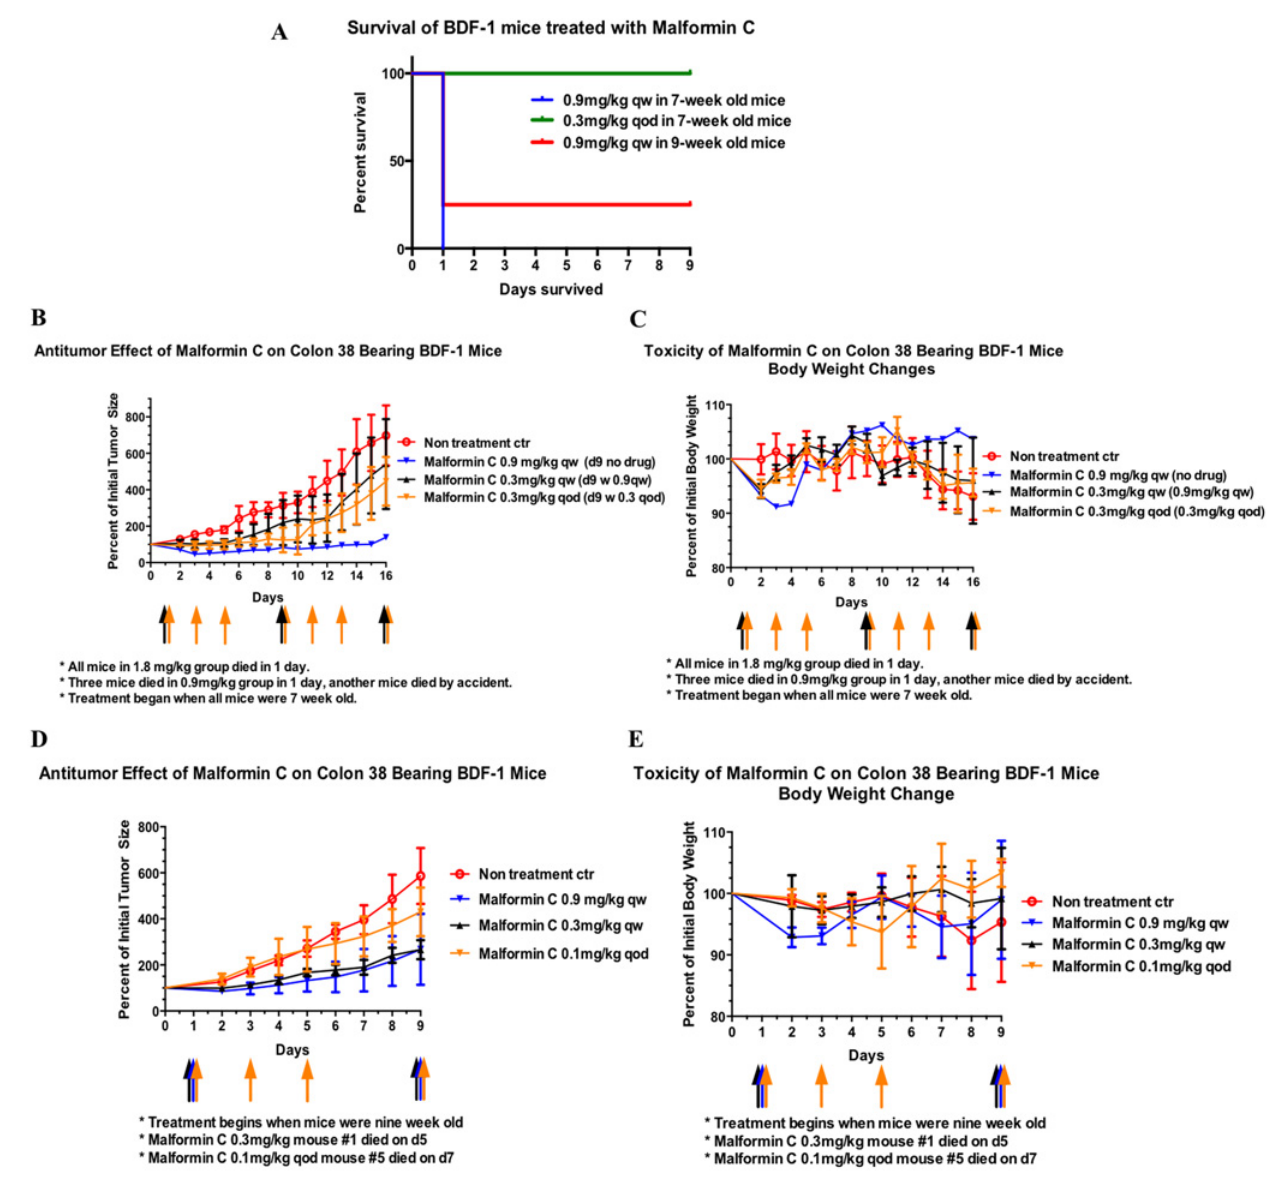
Fig 6. The anti-cancer effects and in vivo toxicity of Malformin C. (A) Survival of BDF-1 mice treated with Malformin C. All the mice in 2.6mg/kg and 1.8mg/kg group died within 1 day after injection, and all the mice in 0.3mg/kg and 0.1mg/kg survived throughout the experiment. There were 5 mice in each group and the week age indicated was that at the beginning of the experiment. One of the mice in 0.9mg/kg qw 7-week old group died by accident and was therefore excluded from the graph. Malformin C was given by i.p., qw means every week, qod means every other day. (B) Tumor growth of Colon 38 bearing BDF-1 mice treated with Malformin C. All the mice were 7 weeks old on Day 0. Control group was treated with 0.1ml/10g PBS (the intake volume was the same for all groups), 0.9mg/kg group was injected with Malformin C on Day 1, 0.3mg/kg q.w. group was treated with 0.3mg/kg on Day 1 and treated with 0.9mg/kg on Day 9 in order to confirm age and toxicity effect, 0.3mg/kg q.o.d. group was treated with 0.3mg/kg Malformin C on Day 1, 3, 5, 9, 11, 13 and 16. (C) Body weight changes of corresponding groups in A were measured. (D) Tumor growth of Colon 38 bearing BDF-1 mice treated with Malformin C. All the mice were 8 weeks old on Day 0. Control group was treated with 0.1ml/10g PBS, 0.9mg/kg group was injected with Malformin C on Day 1 and 9, 0.3mg/kg q.w. group was treated with 0.3mg/kg on Day 1 and 9, 0.1mg/kg q.o.d. group was treated with 0.1mg/kg Malformin C on Day 1, 3, 5 and 9. (E) Body weight changes of corresponding groups in C were